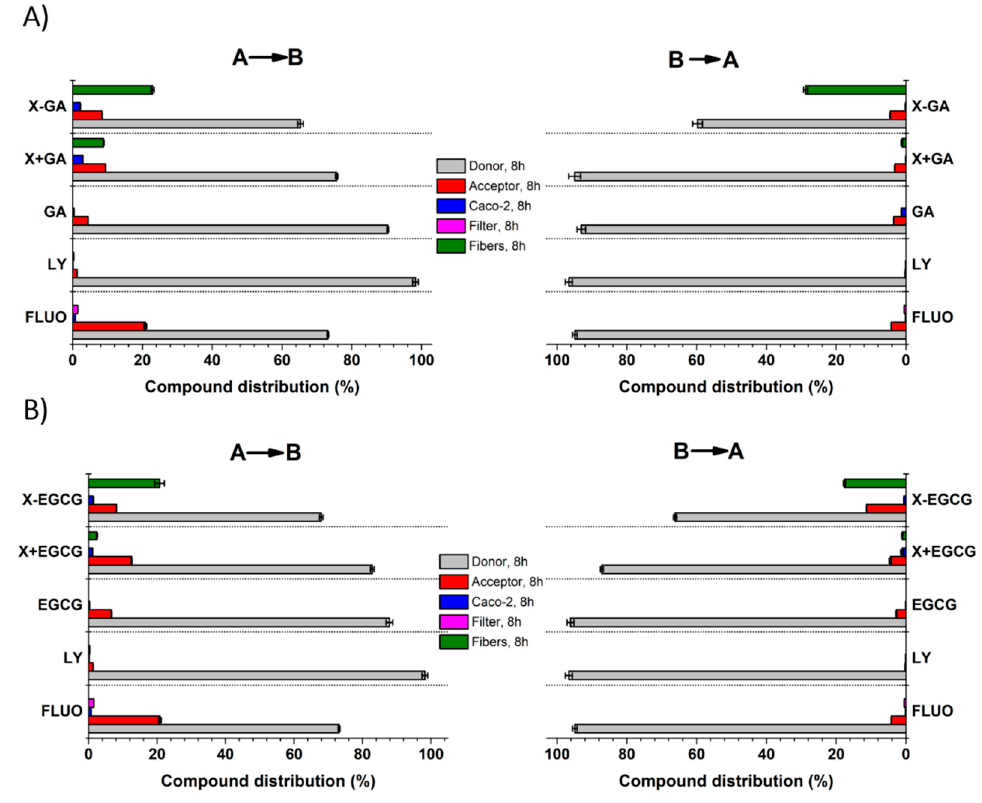
Figure 8. Quantification of GA ( A ) and EGCG ( B ) distribution in the donor side, acceptor side, cell lysate, membrane insert, and fibers after 8 h transepithelial transport in both AB and BA directions. All data are the mean ± SD of three independent experiments.